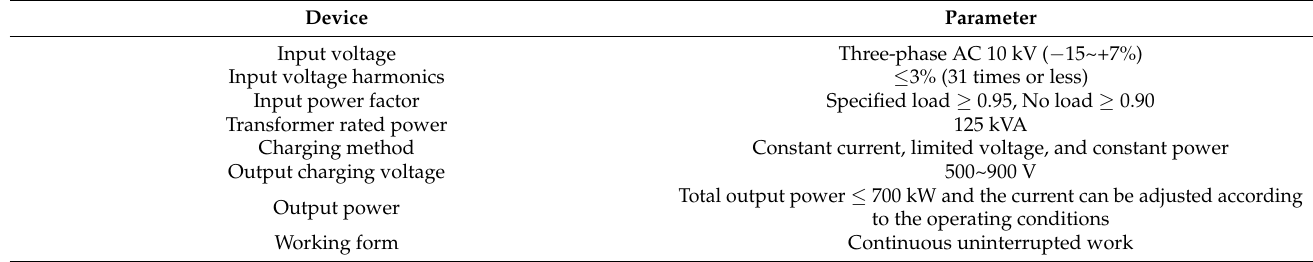
Table 2. The main technical